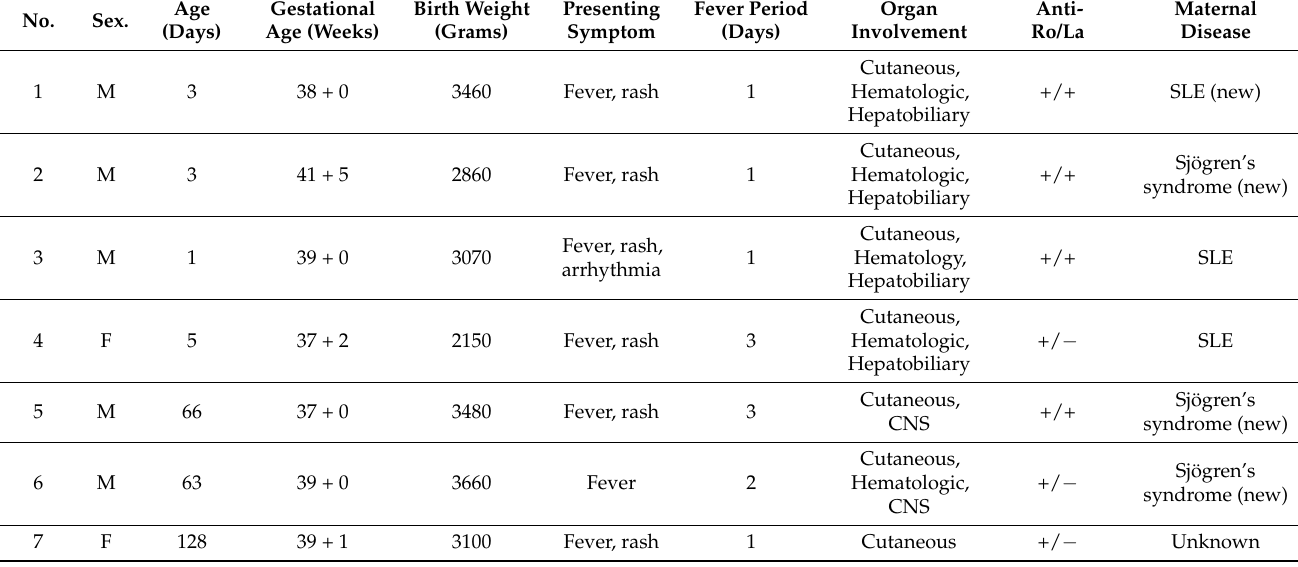
Table 2. NLE patients with fever ( n =